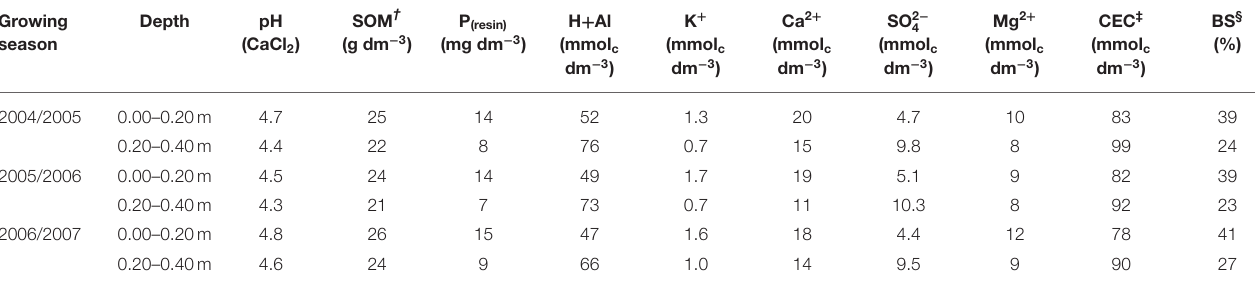
TABLE 1 | Soil chemical characteristics at two depths in the experimental areas before initiating the experiment ( n = 8). Growing